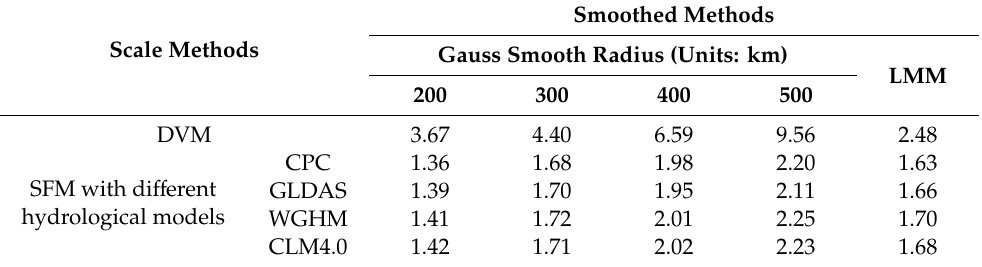
Table 1. Scale factors from different methods. CLM4.0: Community Land Model, CPC: Climate Prediction Center, DVM: scale factor independent of the hydrological model proposed by Dutt Vishwakarma et al. [65]; GLDAS: Global Land Data Assimilation System, LMM: Lagrange multiplier method; SFM: scale factor method, WaterGAP Global Hydrology Model.